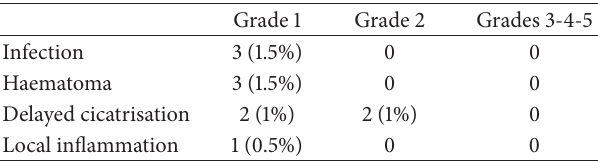
Table 3: Acute toxicities according to NCI Common Terminology Criteria for Adverse Events version 3.0.